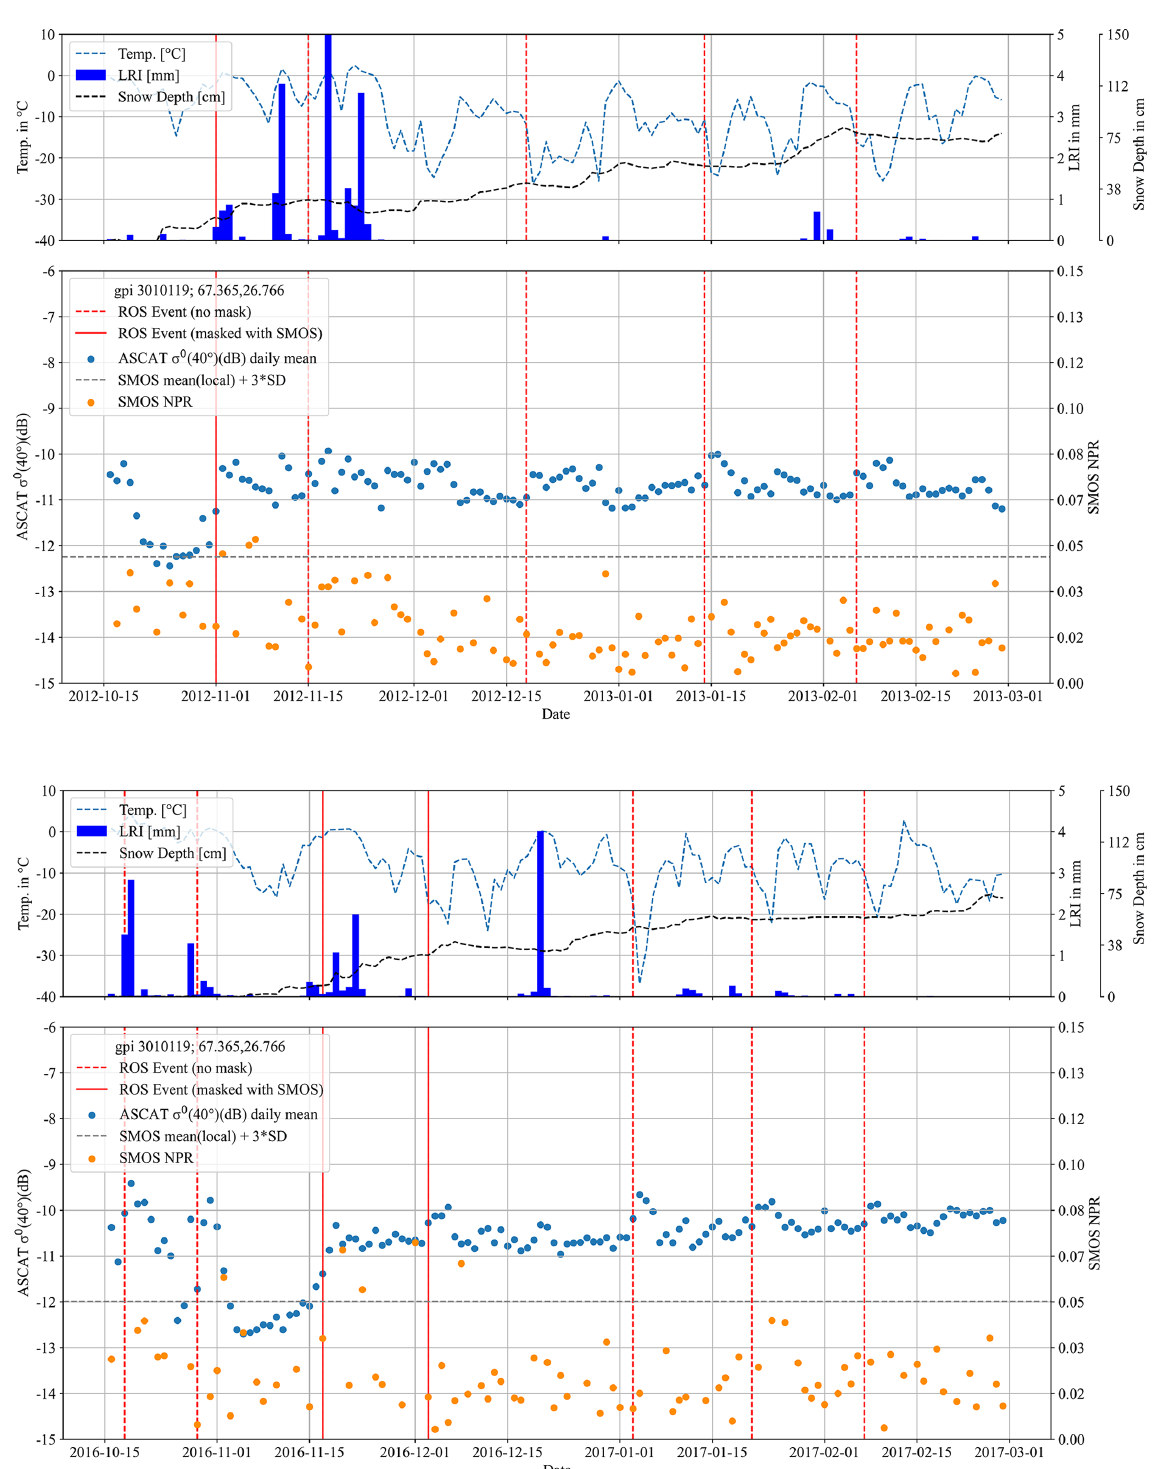
Figure 3. Examples of the influence of temperature drops on the rain-on-snow detection based on ASCAT for Sodankylä. Liquid precipitation (LRI) is shown with air temperature and snow depth from the automatic weather station for two selected winter periods. SMOS NPR and the masking threshold (derived from local mean NPR and the high-latitude standard deviation; see Table 2) are shown in addition as horizontal dashed grey line. Vertical lines represent potential rain-on-snow events based on ASCAT only, with solid lines for periods confirmed with high SMOS NPR (wet